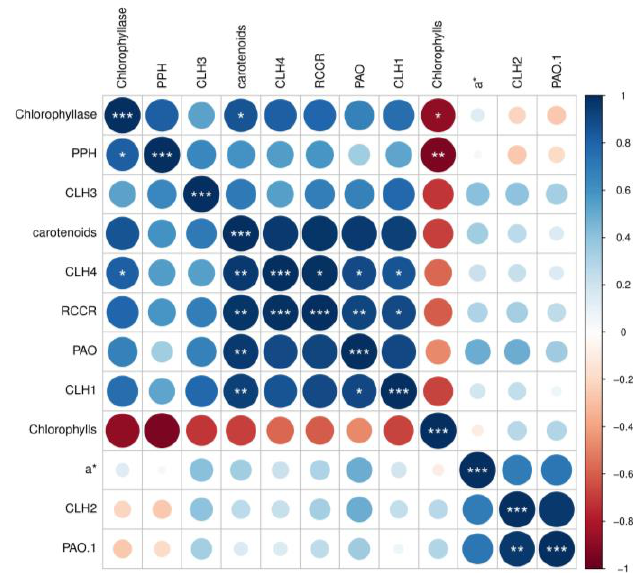
Figure 6. The Pearson correlation coefficient was calculated based on the biochemical parameters and the expression levels of the genes related to the metabolism of chlorophyll in postharvest tomatoes. The heat map was generated based on the correlation of the difference between the 60 kV treatment group and the control group, where PAO.1 is the PAO gene, * is p ≤ 0.05, ** is p ≤ 0.01, and *** is p ≤ 0.001.